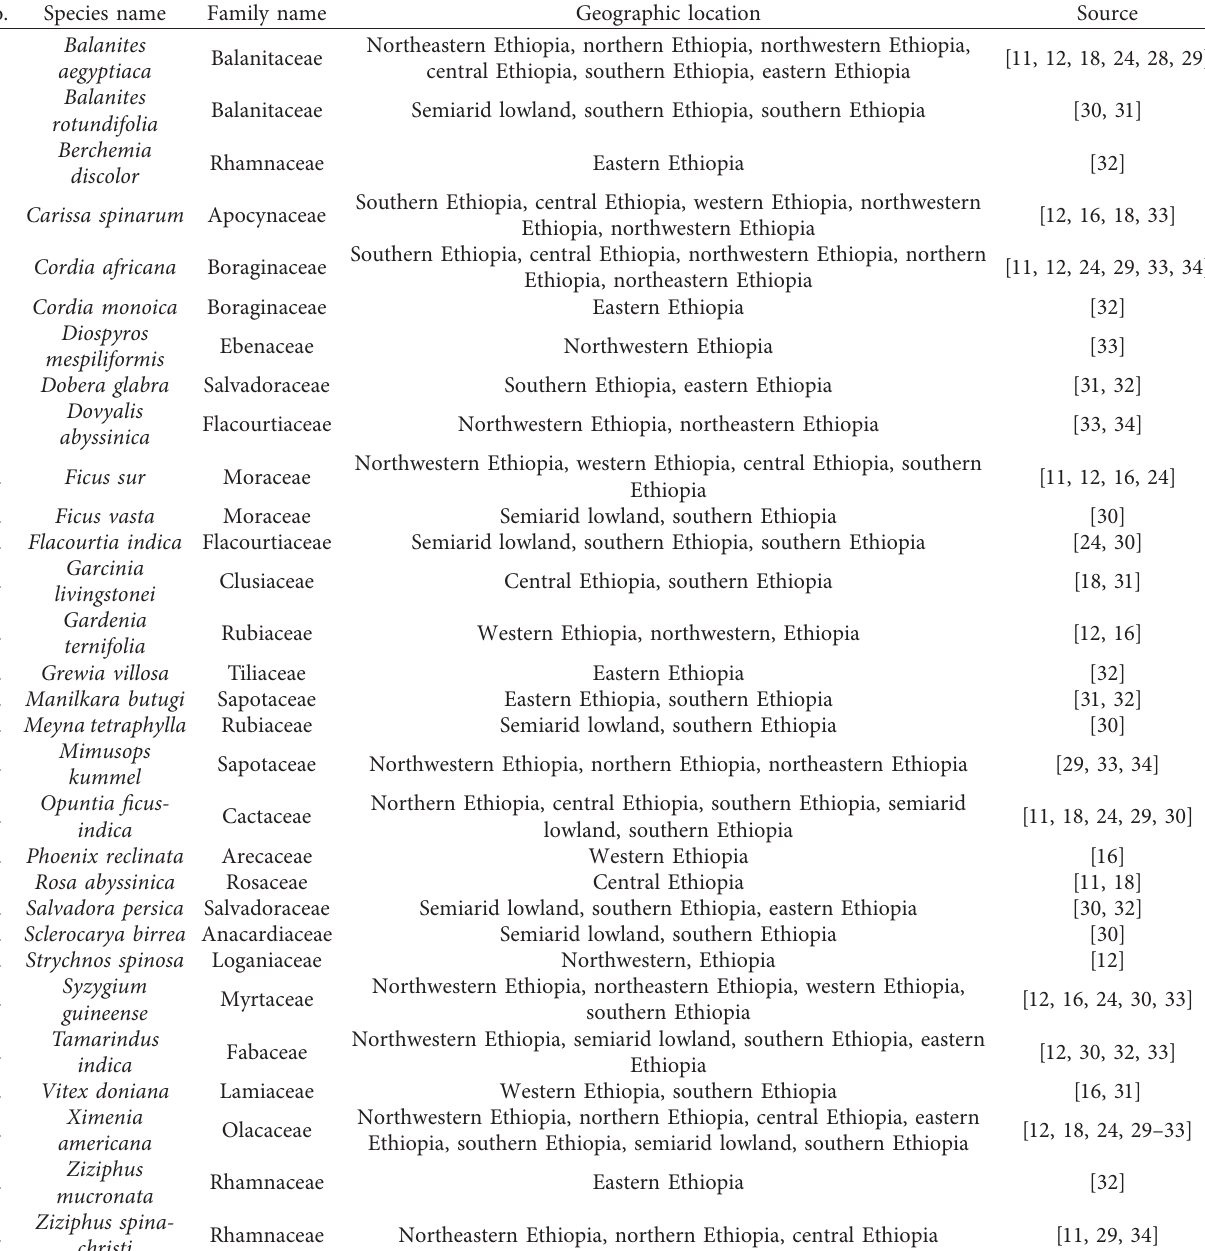
Table 1: Widely utilized wild edible fruit species in different geographic locations of